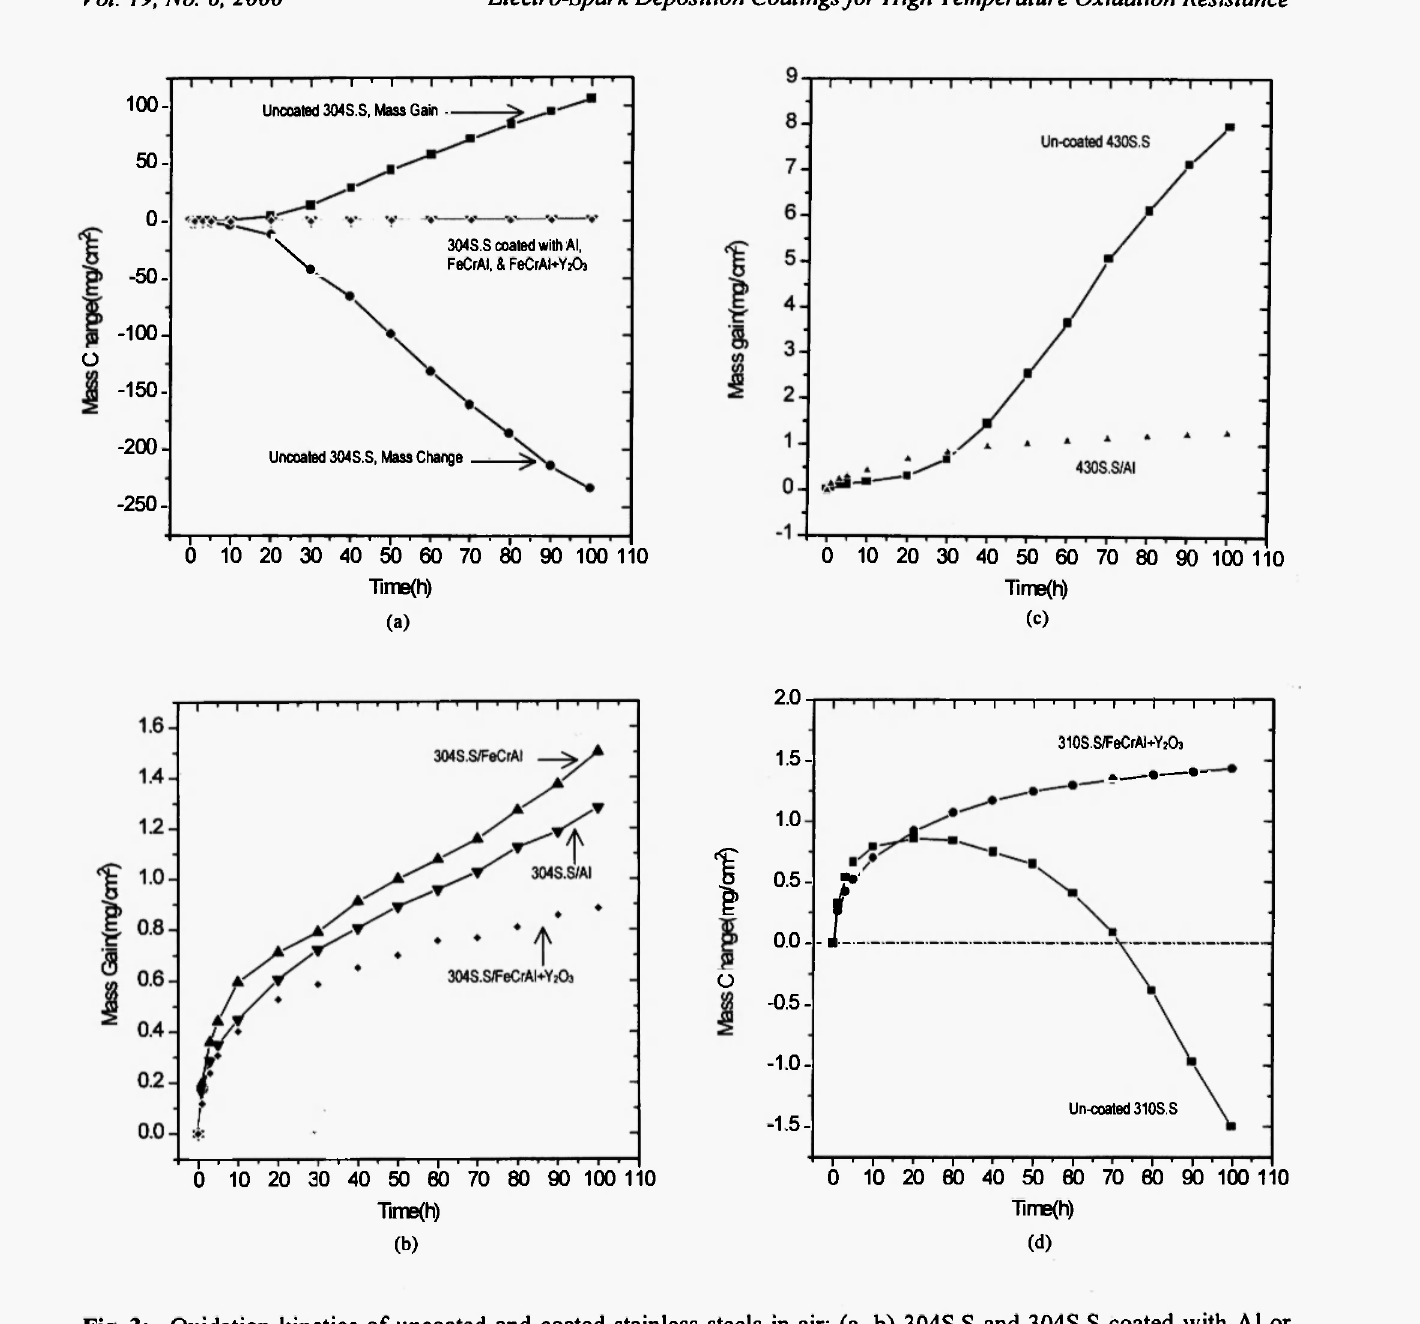
Fig. 3: Oxidation kinetics of uncoated and coated stainless steels in air: (a, b) 304S.S and 304S.S coated with Al or FeCrAI (Y 2 0 3 ) at 1000°C; (c) 430S.S and 430S.S coated with Al at 900°C; and (d) 310S.S and 310S.S coated with FeCrAI + Y 2 0 3 at 1100°C